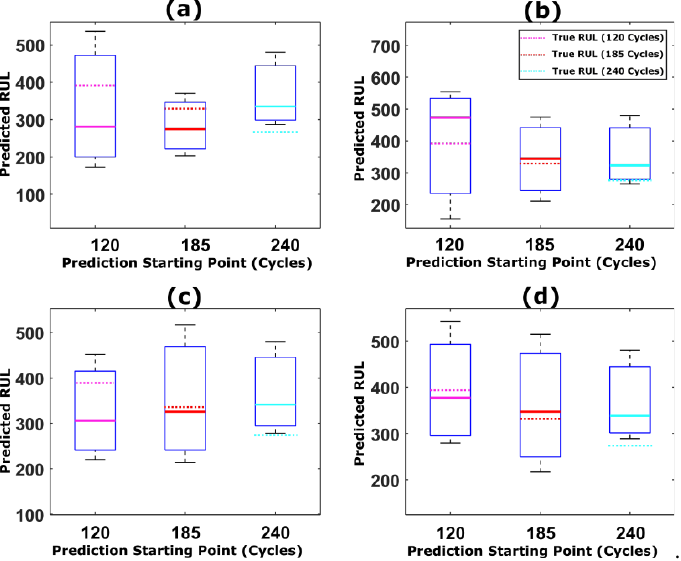
Figure 15. Box plot showing the comparison between predicted RUL and true RUL for CALCE dataset (CS-37) for three different prediction starting points using ( a ) MR, ( b ) StR, ( c ) SyR, and ( d ) particle roughening methods .